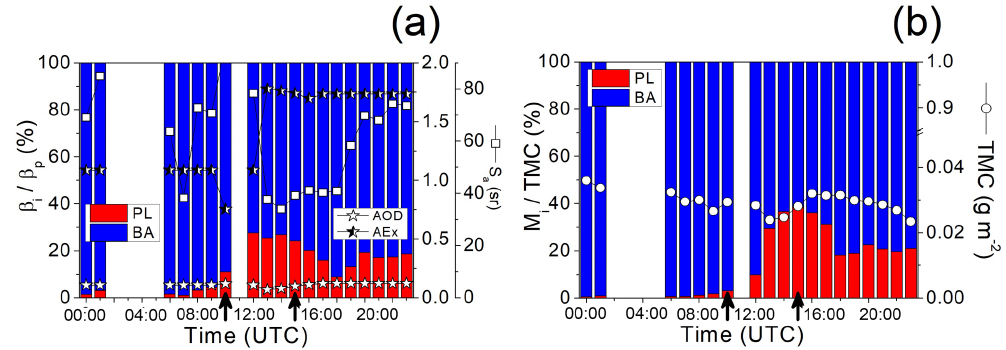
Figure 7. The same as Fig. 3 but for the pollen event that occurred on 23 March 2016: PL (red bars) and BA (blue bars) denote pollen and local background aerosol components. Black arrows on the time axis indicate selected times for those vertical profiles shown in Fig. 8.